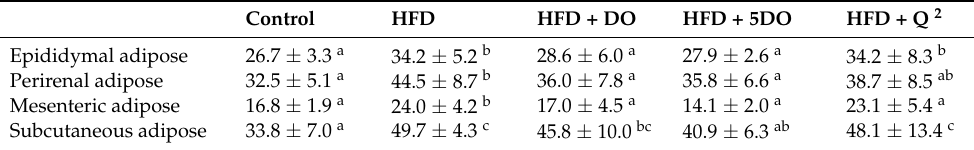
Table 2. Effect of dried onion powder and quercetin on body lipid in Sprague Dawley rats exposed to HFD 1 .